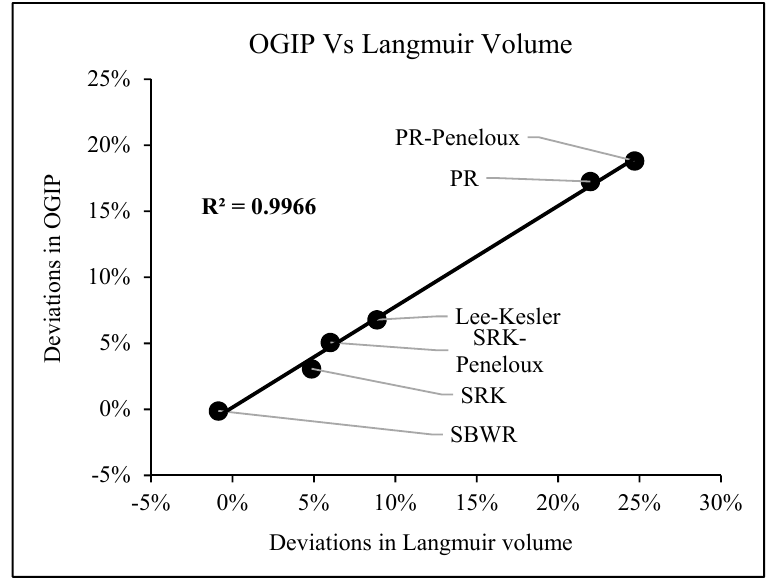
Figure 9. Relationship between calculated gas reserves and Langmuir volume.